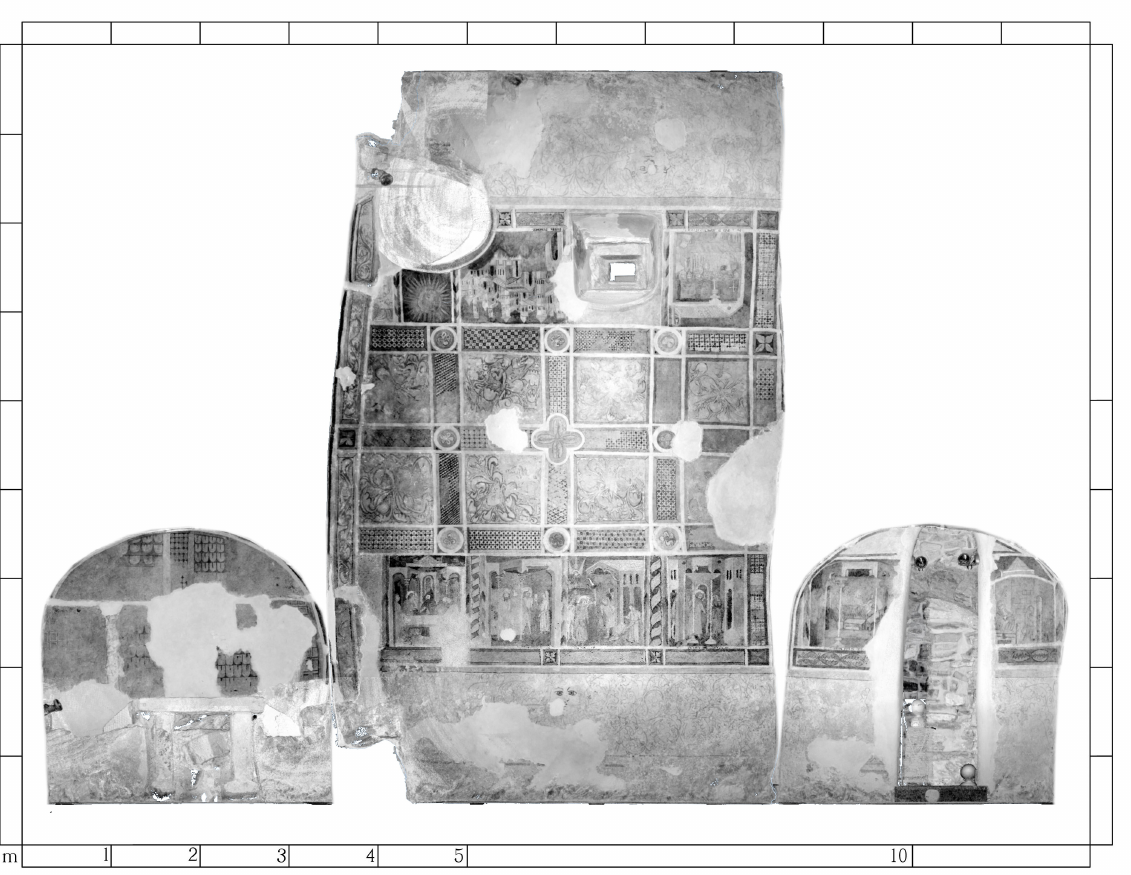
Figure 10. The barrel vault of the chapel was completely unfolded for observing the real shapes of the pictorial